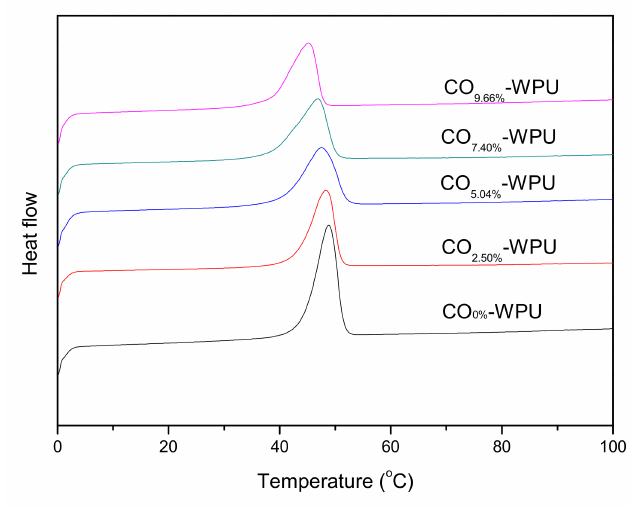
Figure 5. XRD-Ray diffraction pattern of WPU films.